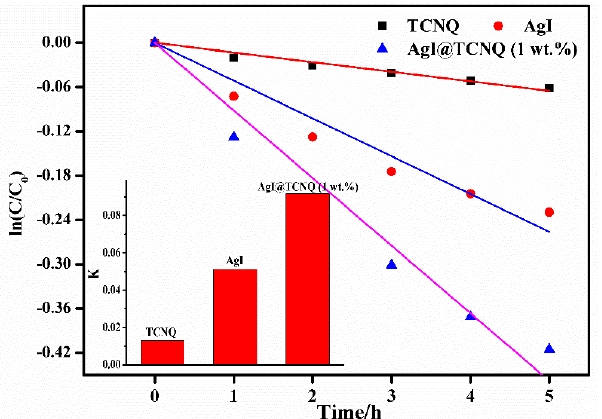
Figure 10. Photocatalytic degradation of phenol; (inset) the apparent rate constants over pure TCNQ, AgI, and AgI@TCNQ (1 wt.%).